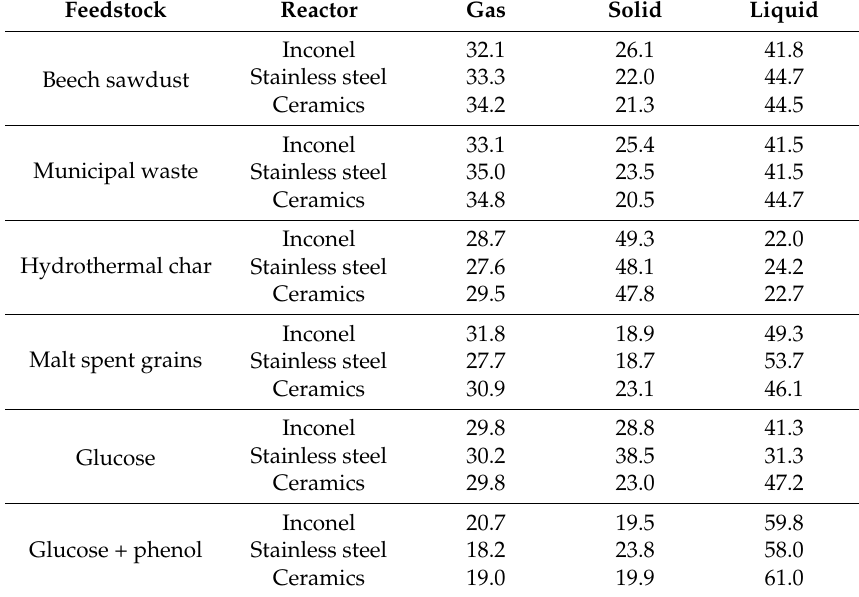
Table 2. Yields of gas, solids, and liquids for the performed experimental tests. Values are expressed in wt %. Liquid is calculated by difference. Experimental error: gas: ± 0.4; solid: ± 2.0; liquid: ± 1.5.